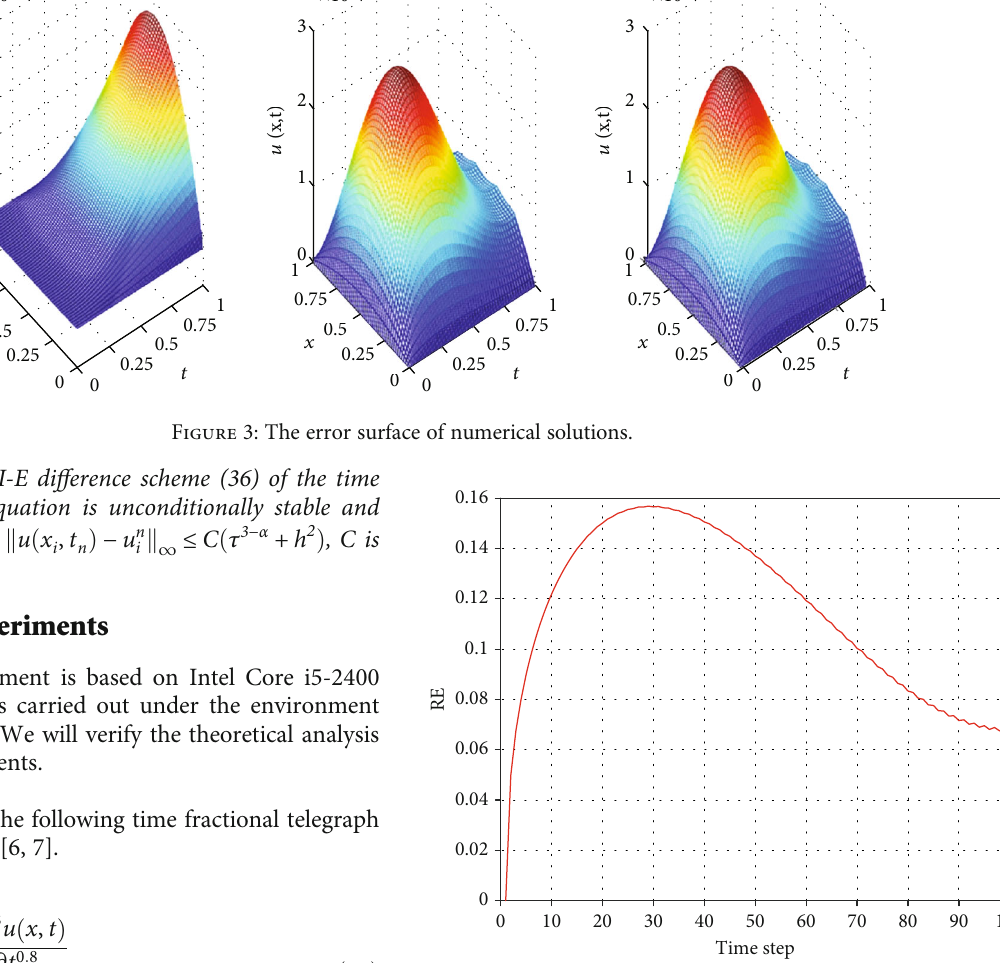
Figure 4: The curve of RE changes with time.